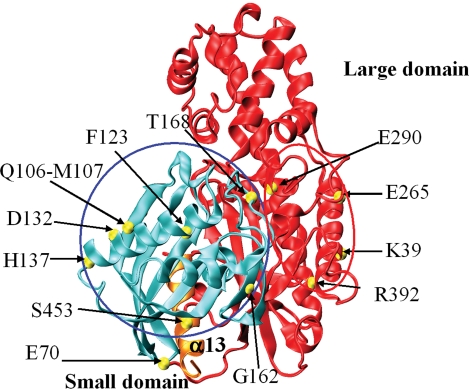
Distribution of the GCK mutations.The structure of GCK in the closed form (PDB code: 1v4s) is shown as cyan and red ribbons that represent the small and large domain, respectively. Orange ribbons show the α13 helix. Yellow spheres are the mutation sites. Red and blue circles indicate clusters of mutations in the large and small domain, respectively.